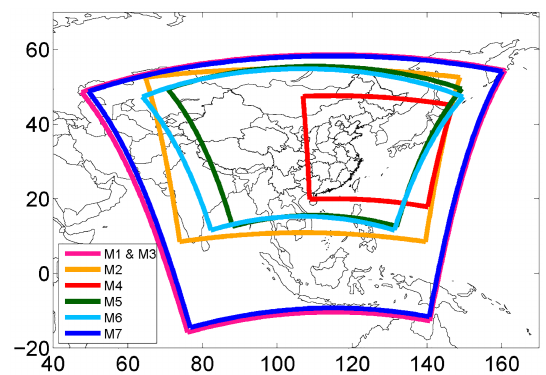
Figure 1. MICS-Asia III Topic 3 modeling domains (descrip- tions of each model are documented in Table 1). M1: WRF-Chem 45km; M2: WRF-Chem 50km; M3: NU-WRF 45km; M4: NU- WRF 15km; M5: RIEMS-Chem 60km; M6: RegCCMS 50km; M7: WRF-CMAQ 45km.